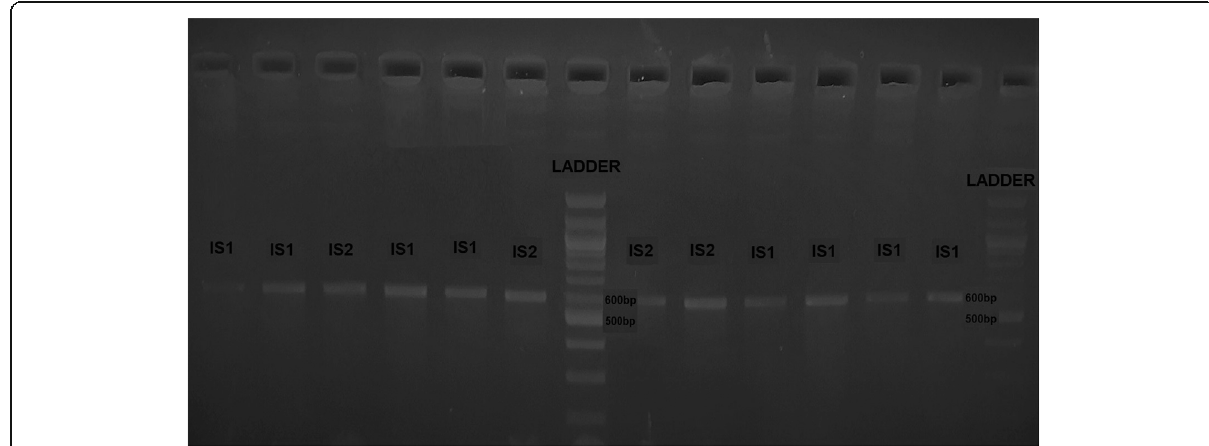
Fig. 1 ITS4-5 amplicon gel electrophoresis results; IS1: isolate 1, IS2 isolate 2, 1, 5% gel electrophoresis, 45 min run with 60 V. 100-bp ladder was used for identification of the exact amount of amplicons